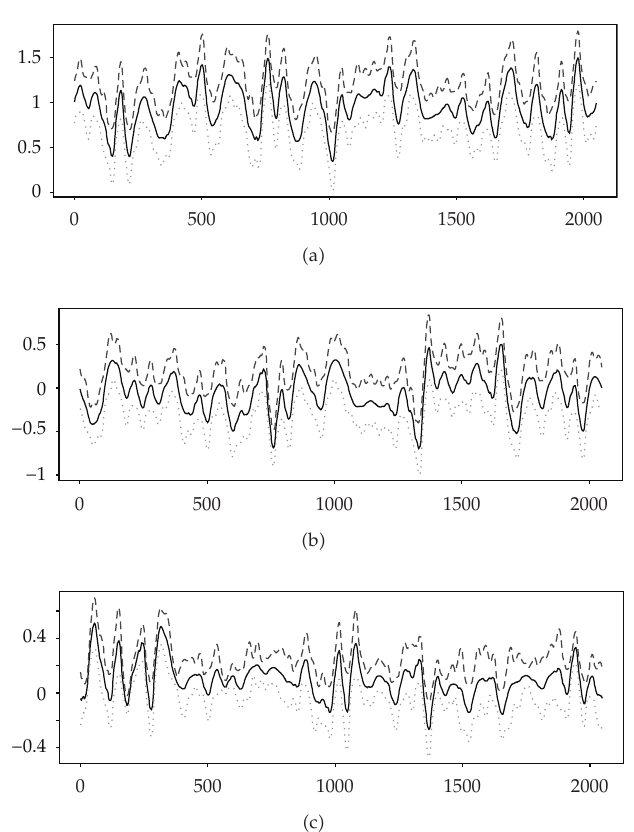
Figure 16: Model M 3 : Bootstrap 95% confidence regions for (cid:5) a (cid:6) δ 1 (cid:5) u (cid:6) , (cid:5) b (cid:6) δ 2 (cid:5) u (cid:6) , (cid:5) c (cid:6) ω 0 (cid:5) u (cid:6) , using nonlinear